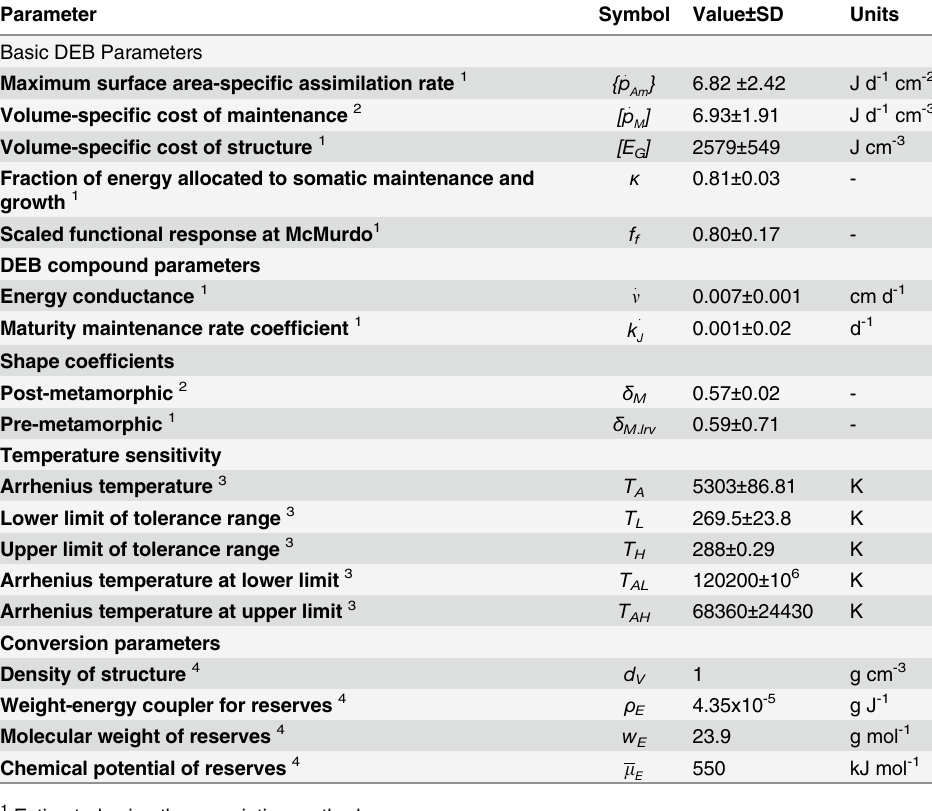
Table 1. DEB parameters values for Odontaster validus . These parameters are given for a temperature of 285 K. Parameter Symbol Value ± SD Units Basic DEB Parameters Maximum surface area-speci fi c assimilation rate